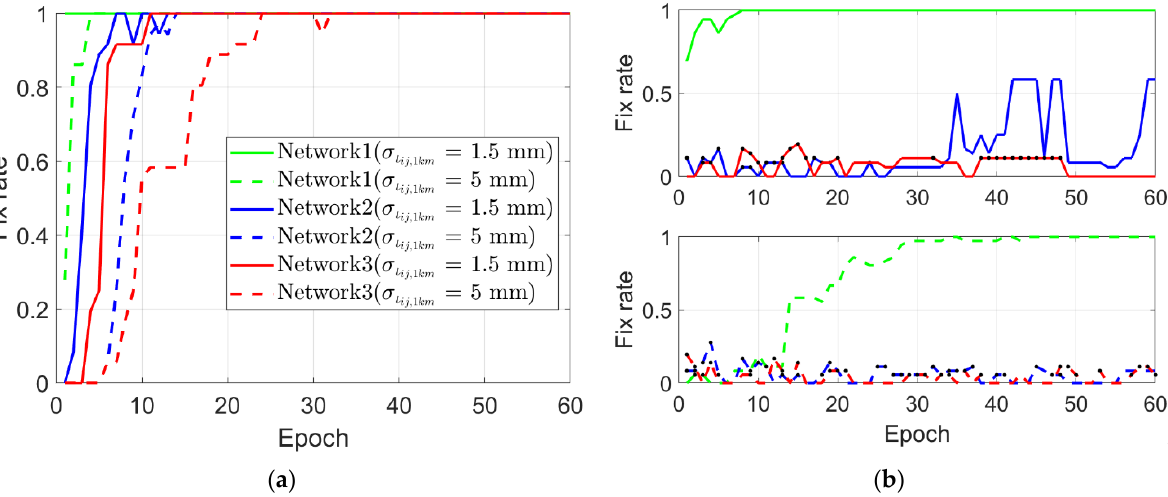
Figure 7. Ambiguity fix rate using PAR for different network sizes and ionosphere activities for: ( a )